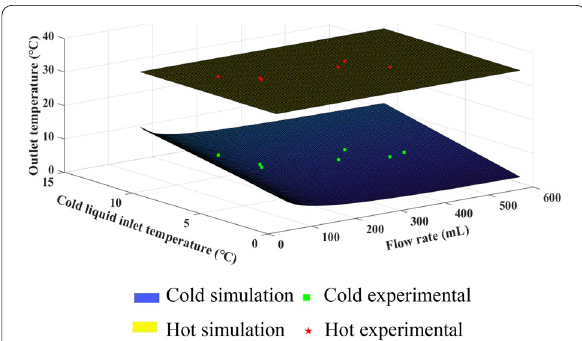
Figure 7 Comparison of output temperature trend curves influenced by input flow and temperature during countercurrent